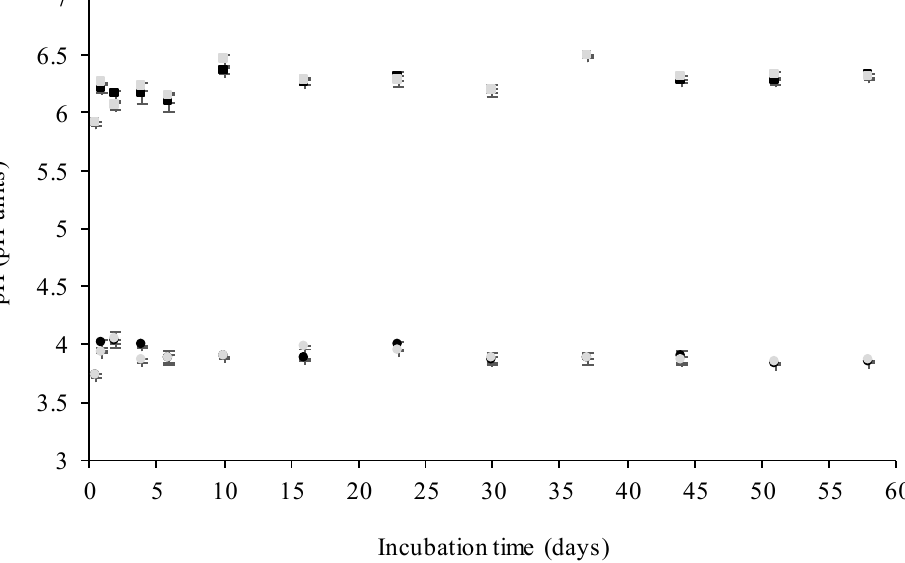
Figure 6. Effect of lime on soil pH following the application of urea (black) or DMPP–urea (grey) to an acidic Gleysol incubated for 65 days at 25 °C and 60% WFPS. Squares indicate limed soil, circles indicate unlimed soil. Error bars depict SEM ( n = 3).